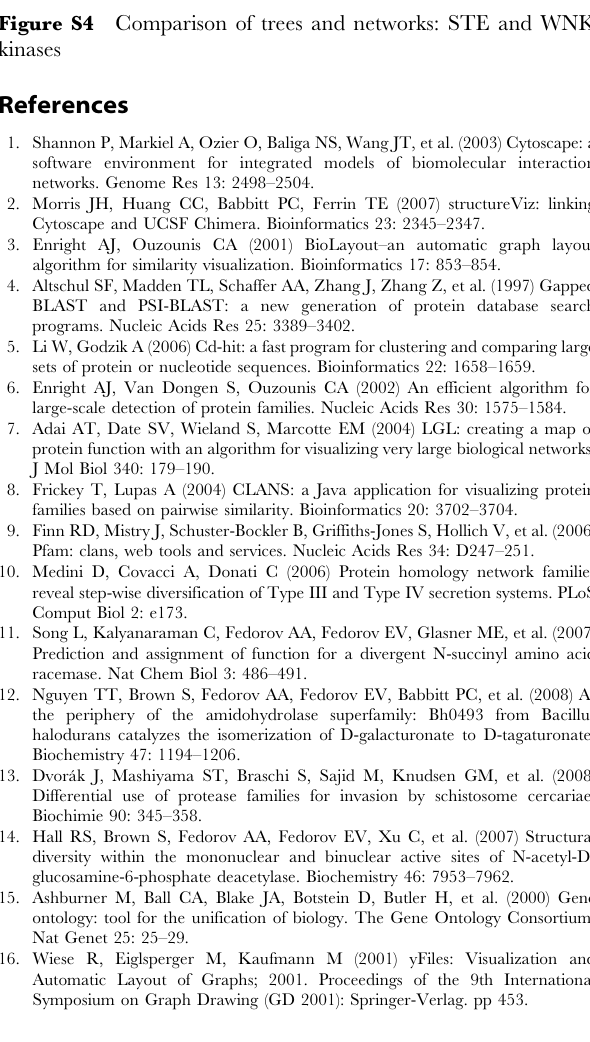
Figure S5 The archaeal bECH ECH domain is more similar to the sECH domain than the non-archaeal bECH ECH domain Found at: doi:10.1371/journal.pone.0004345.s008 (1.11 MB Figure S6 Asymmetery in BLAST E-values: How large is the difference between the E-values calculated between sequence pair A,B when A is used as query, or B is used as query? Found at: doi:10.1371/journal.pone.0004345.s009 (0.43 MB PDF) Figure S7 Example percent identity and length of alignment quartile plots Found at: doi:10.1371/journal.pone.0004345.s010 (0.22 MB